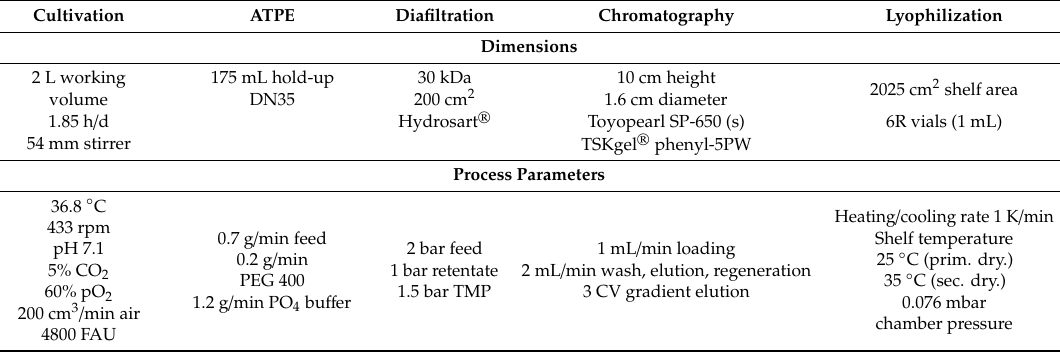
Figure 2. Laboratory set-up of the continuous production of a monoclonal antibody. ATPE (aqueous two-phase extraction), SPTFF (single-pass tangential flow filtration), IPC (interprocess communication), Table 1. Operation parameters and equipment specifications of the operated process. ATPE (aqueous two-phase